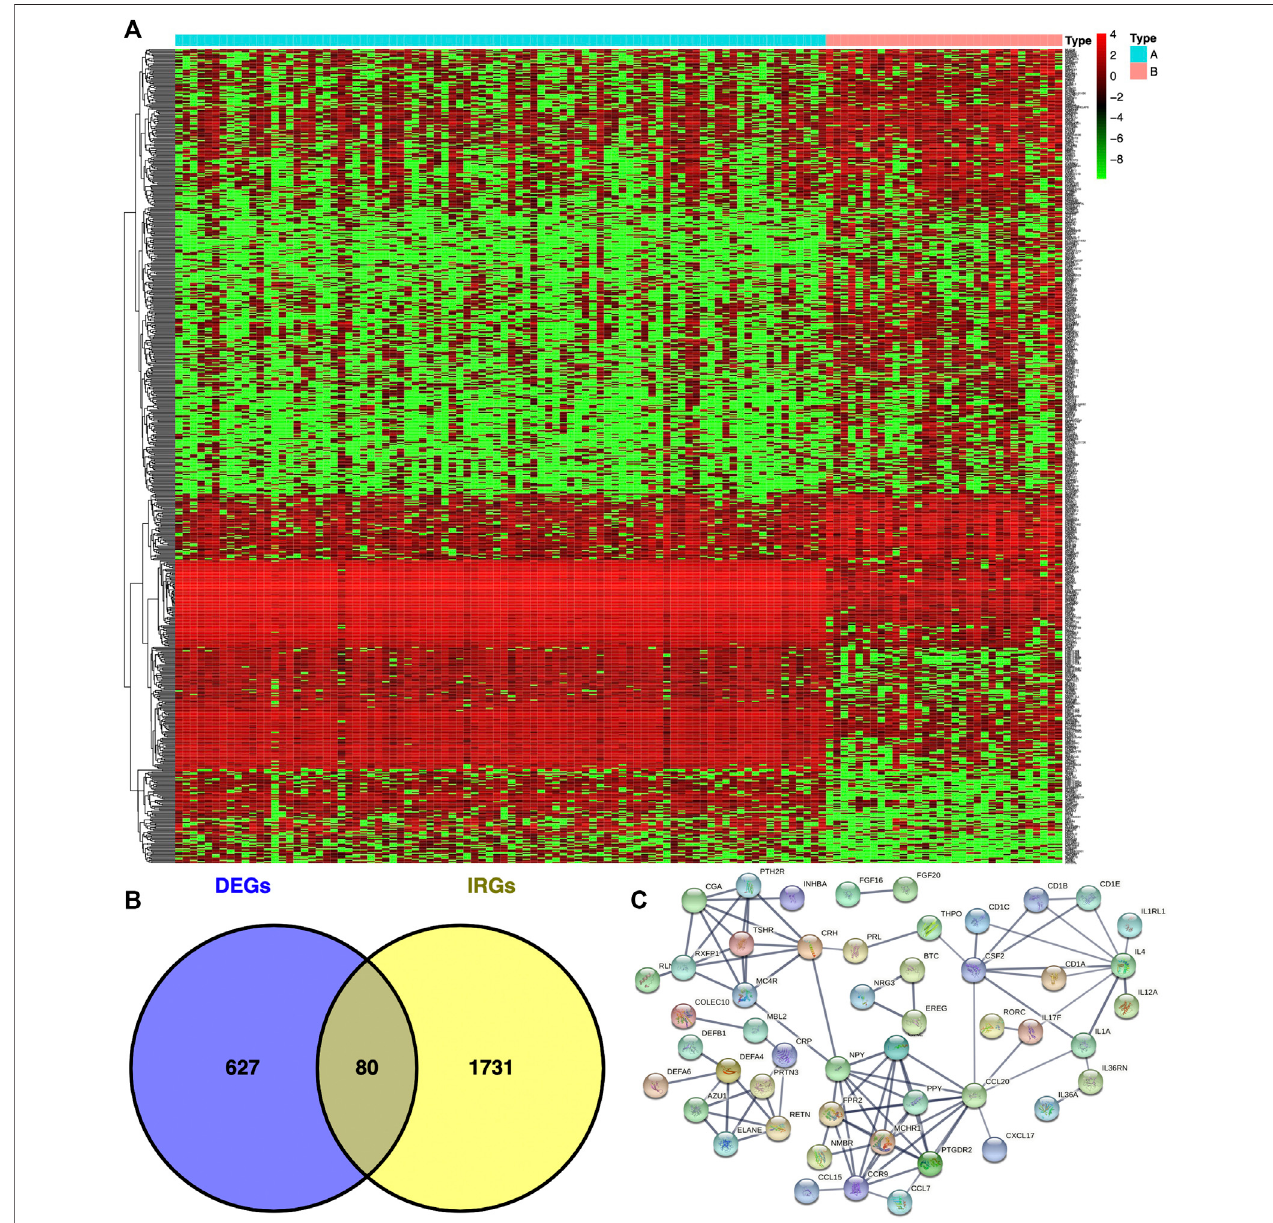
FIGURE 2 | Differentially expressed genes (DEGs) and immune-related genes (IRGs) between immunotypes A and B in THYM. (A) The heatmap shows DEGs betweenimmunotypesAandBinTHYM. (B) TheoverlapbetweenDEGsandIRGsinTHYM. (C) Protein-proteininteraction(PPI)networkofdifferentlyexpressedIRGsin